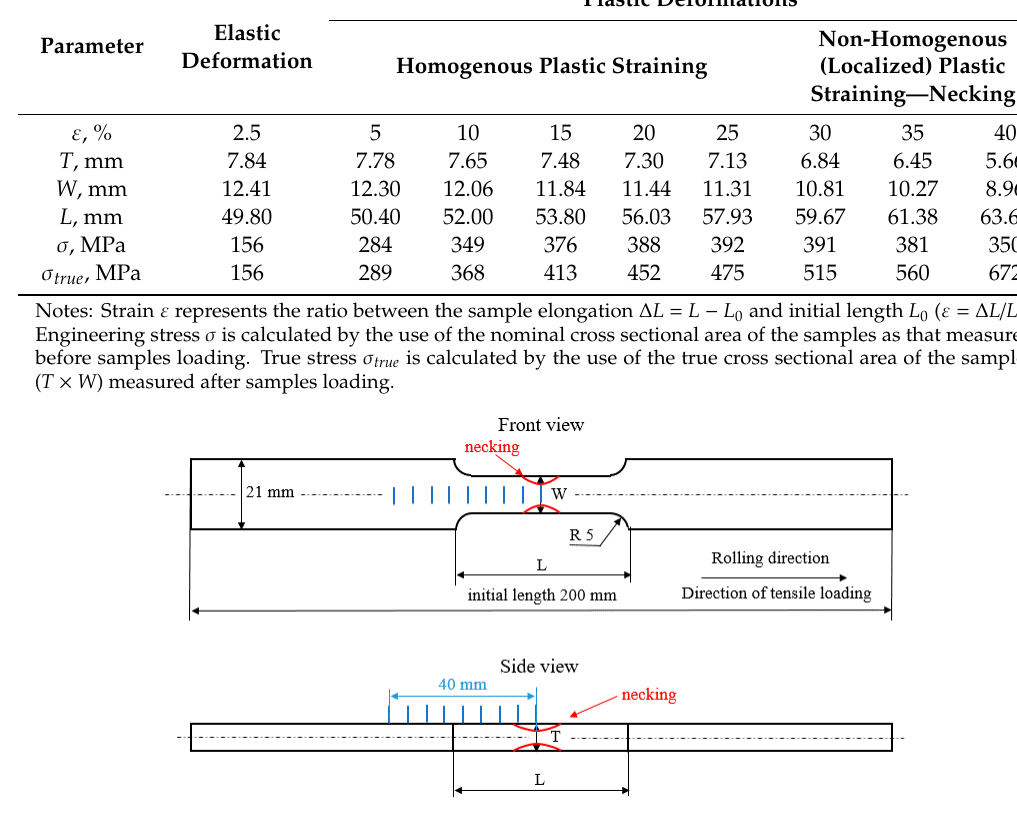
Table 2. Engineering stress σ , true stress σ true , and T , W , L values for the different elastic and plastic strains.